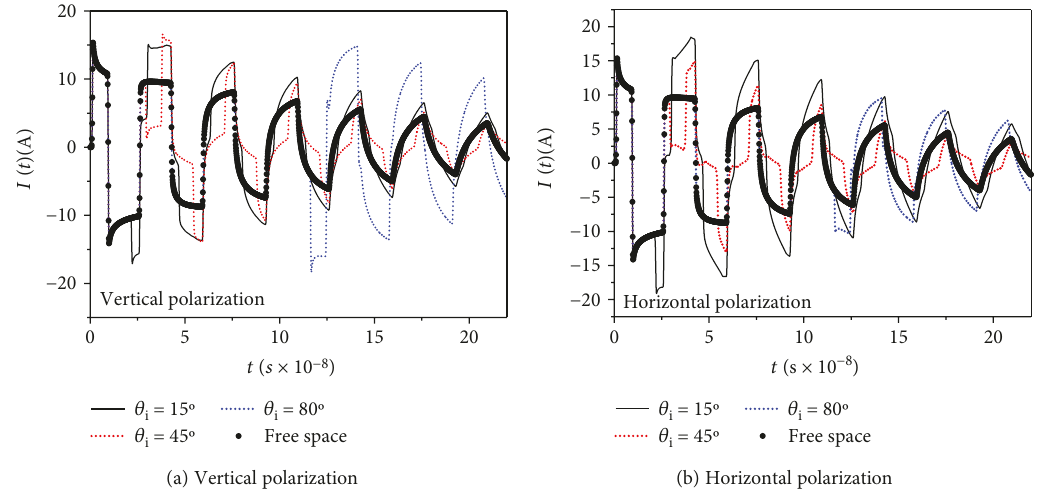
Figure 12: The frequency spectrum of induced current when L = 10 m.